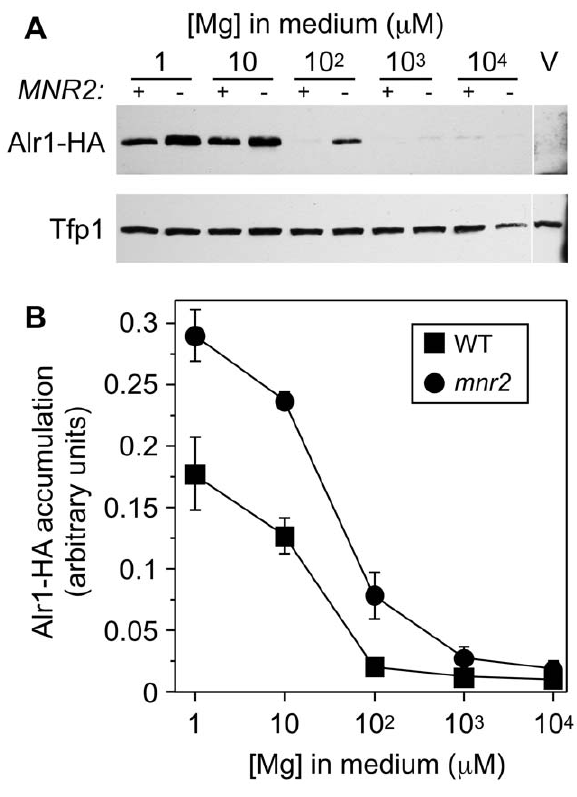
Figure 2. Alr1-HA accumulation varies with Mg supply and MNR2 genotype. ( A ) Alr1-HA accumulation in WT (DY1457) and mnr2 (NP4) strains transformed with YIpALR1-HA were grown to log phase in LMM-ura with the indicated concentration of Mg. Proteins were detected by immunoblotting with anti-HA and anti-Tfp1 antibodies. MNR2 genotype is indicated ( + or 2 ). DY1457 transformed with empty vector was included to show antibody specificity (pFL38, V). ( B ) Quantitation of Alr1-HA accumulation. Immunoblot band density was normalized to the total Alr1-HA signal detected in both strains for each replicate. Values are average of five independent experiments, including the result shown in A. Error bars show + / 2 1 SEM.